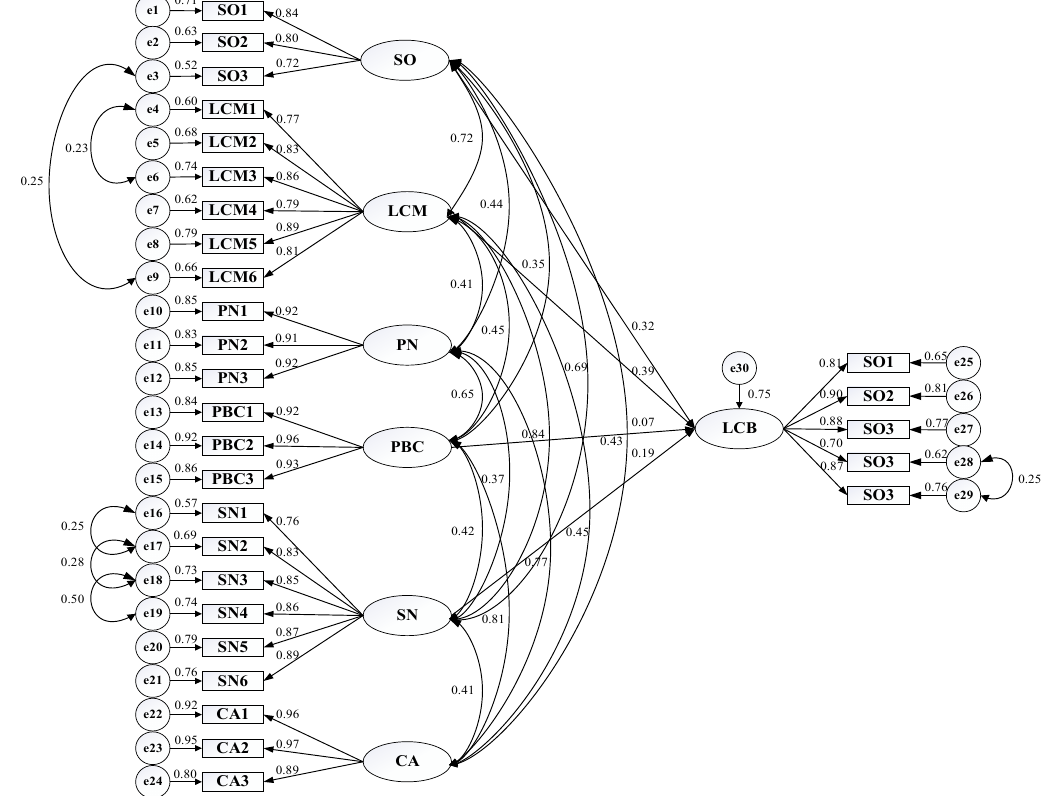
Figure 5. Standardized estimation of the final model (M9).